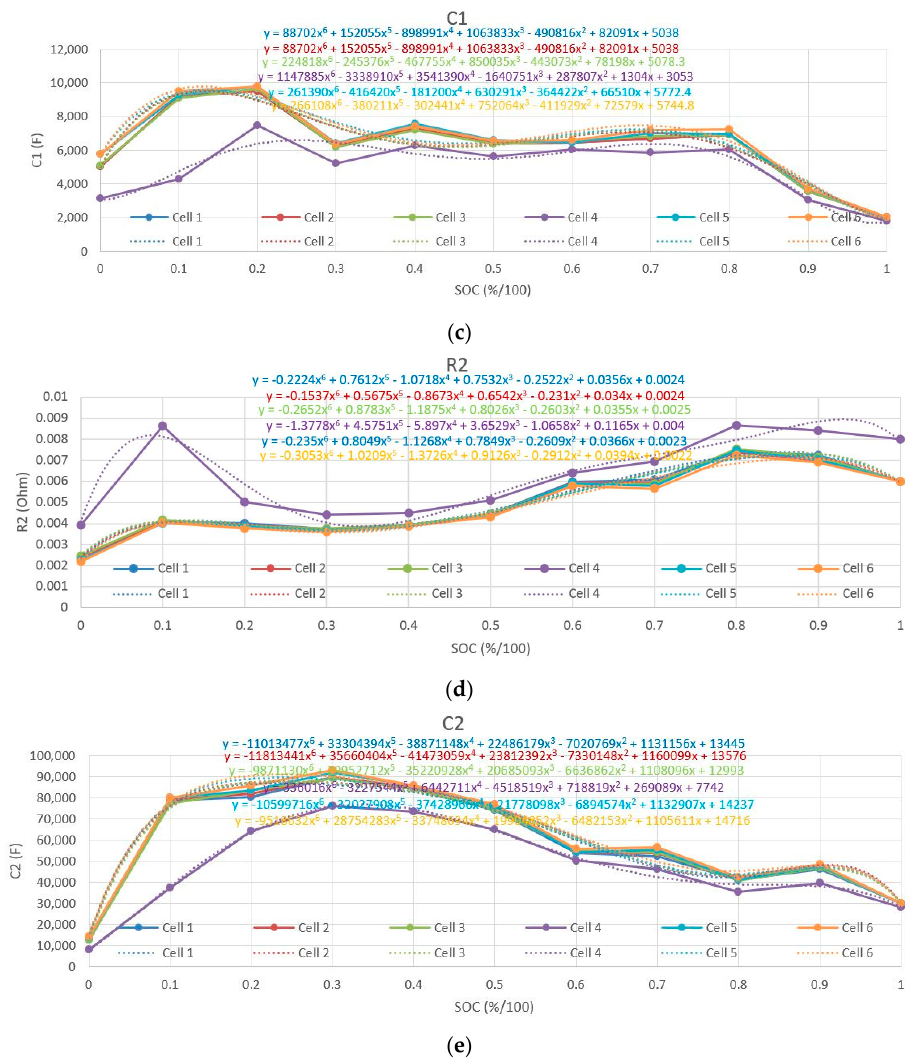
Figure 3. ECM parameter values: ( a ) (cid:1844) (cid:2868) ; ( b ) (cid:1844) (cid:2869) ; ( c ) (cid:1829) (cid:2869) ; ( d ) (cid:1844) (cid:2870) ; and ( e ) (cid:1829) (cid:2870) .